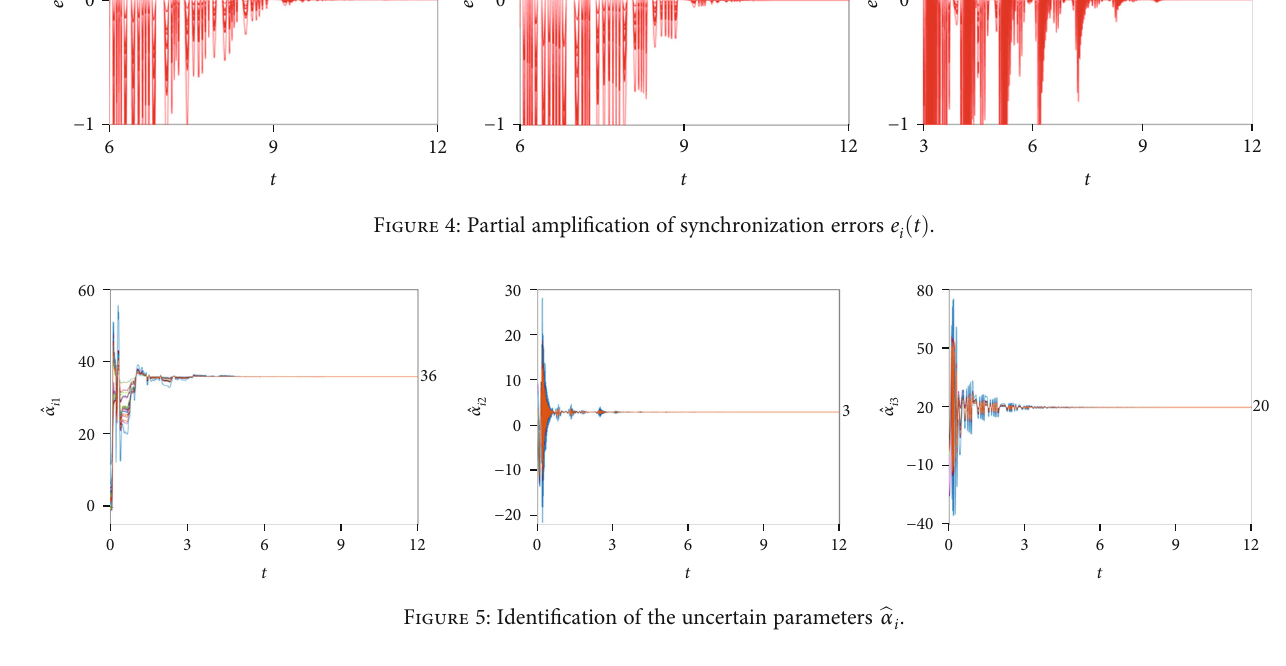
Figure 5: Identi fi cation of the uncertain parameters b α